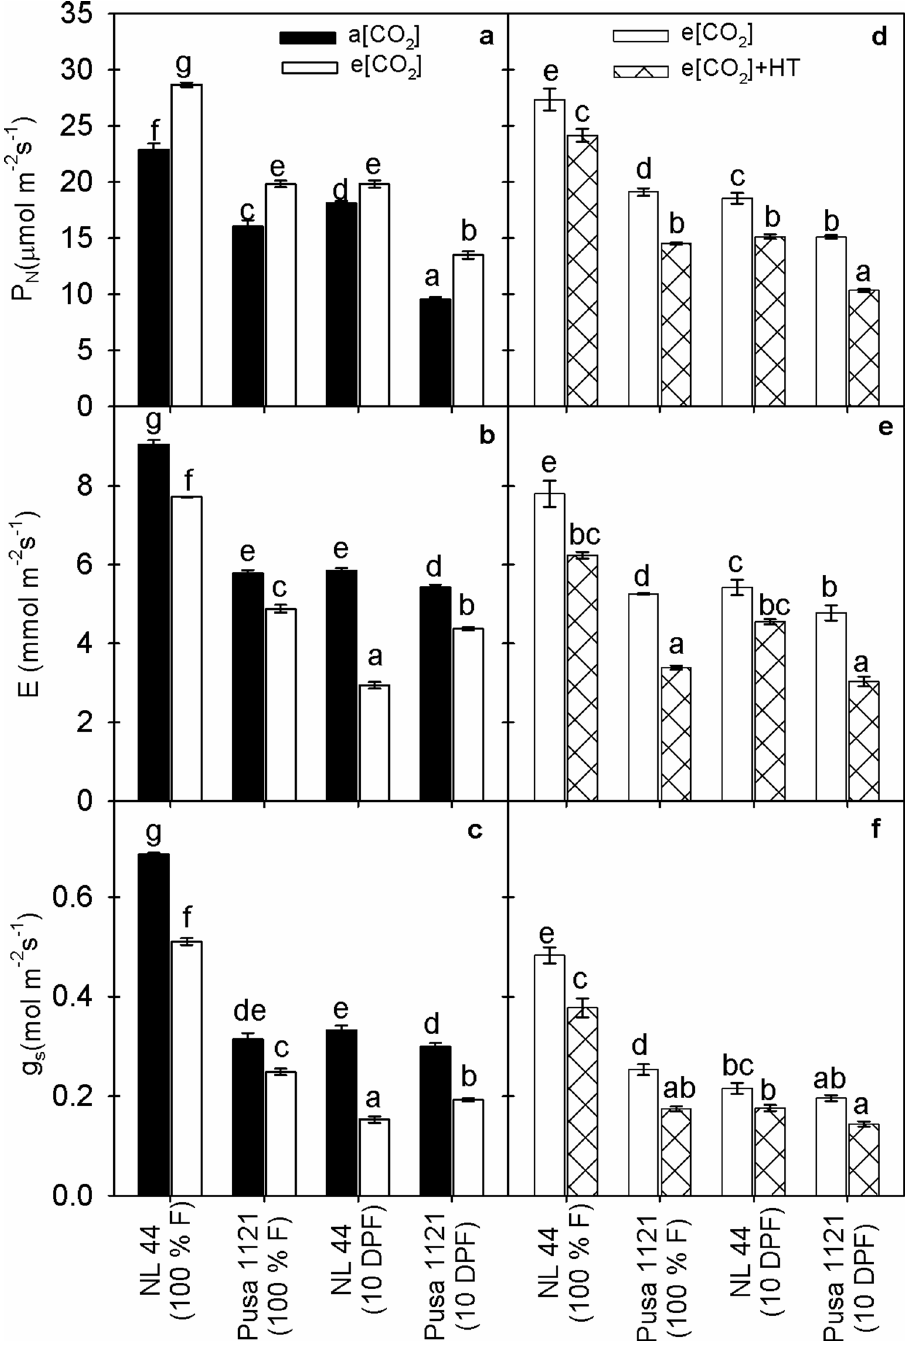
Figure 1. Changes in gas exchange parameters in flag leaf of rice cultivars NL-44 and Pusa-1121 at 100% flowering (100% F) and at 10 days post 100% flowering (10 DPF) under ambient and elevated [CO 2 ] during 2013 ( a – c ) and elevated [CO 2 ] and elevated [CO 2 ] + HT environment during 2014 ( d – f ). Each vertical column represents mean of five replicates. Bars indicate ± SE. Comparison of means was obtained from Tukey’s honest significant difference test individually for 2013 and 2014 experiments. Means with the same letter are not significantly different at 5%. [P N = photosynthetic rate; E = transpiration rate; g s = stomatal conductance; HT = high temperature